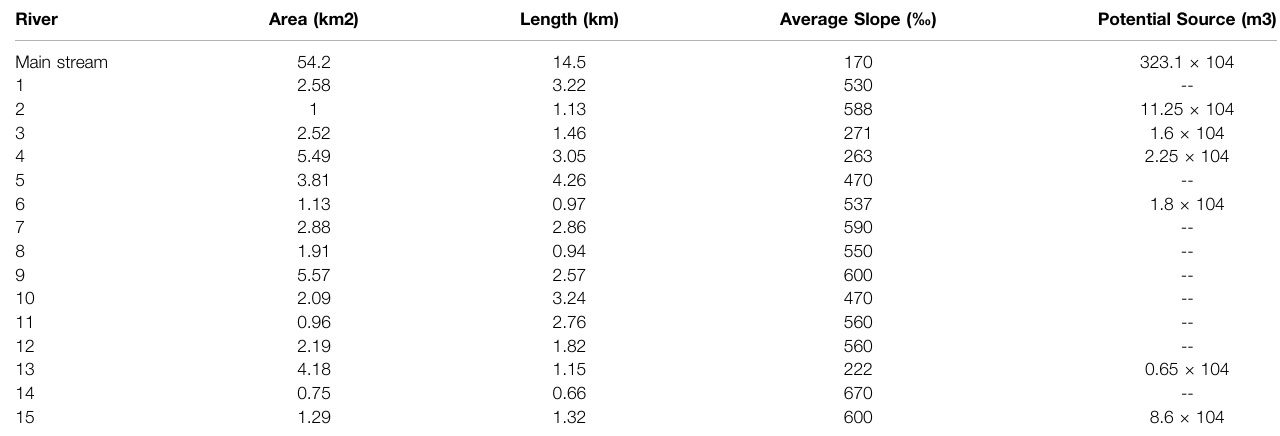
TABLE 1 | Potential debris fl ow sources in the